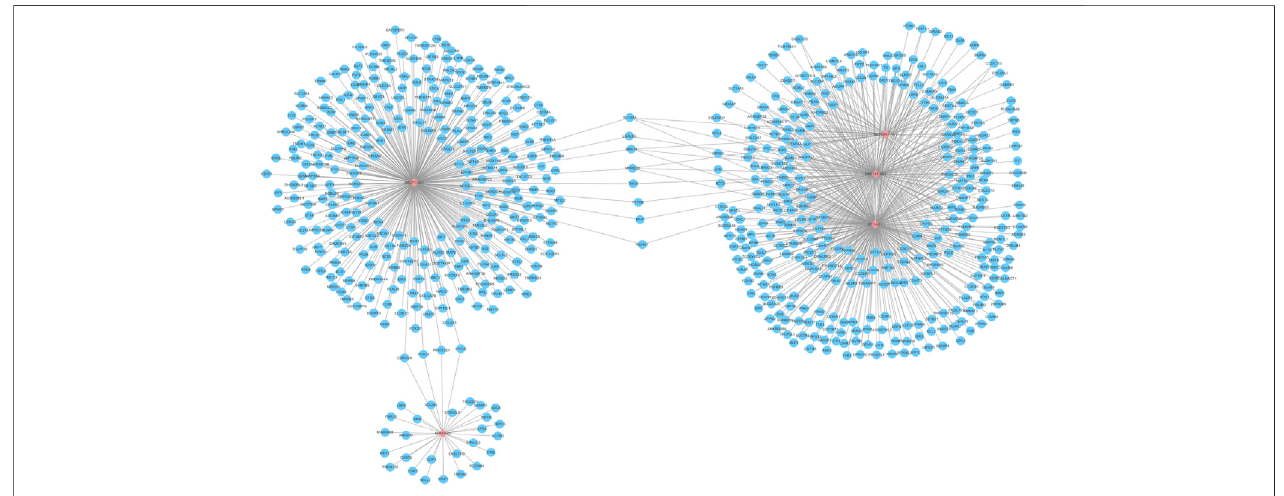
FIGURE 4 | lncRNA-mRNA co-expression network. The network includes the fi ve hub lncRNAs (pink pots) and 650 mRNAs (blue pots).